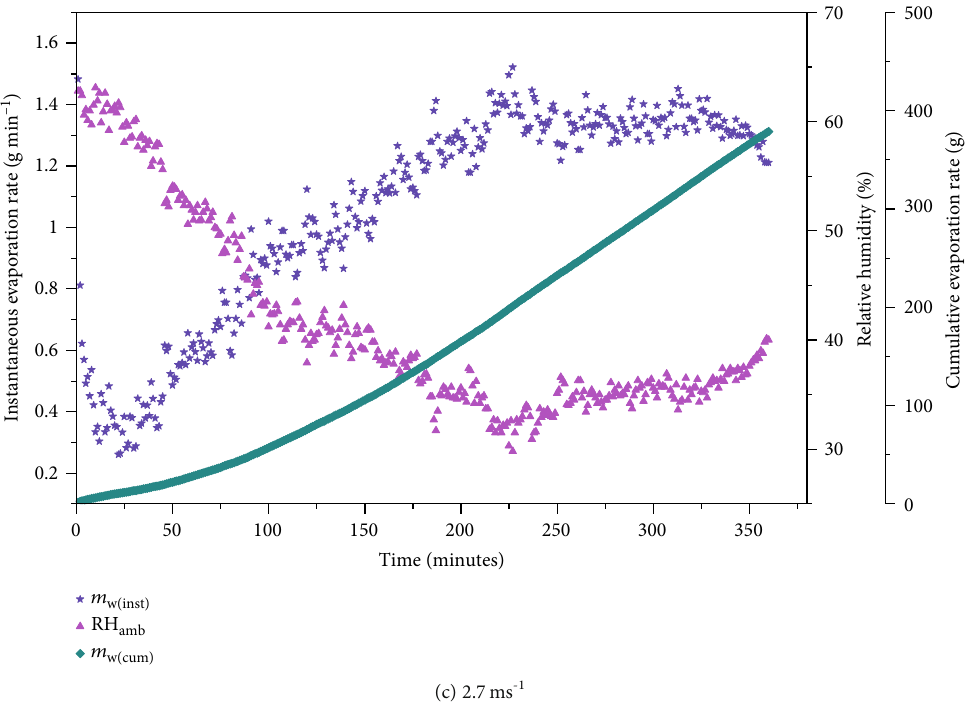
Figure 16: Ambient RH and instantaneous and cumulative evaporation rates of the air cooler at three di ff erent velocities under medium RH